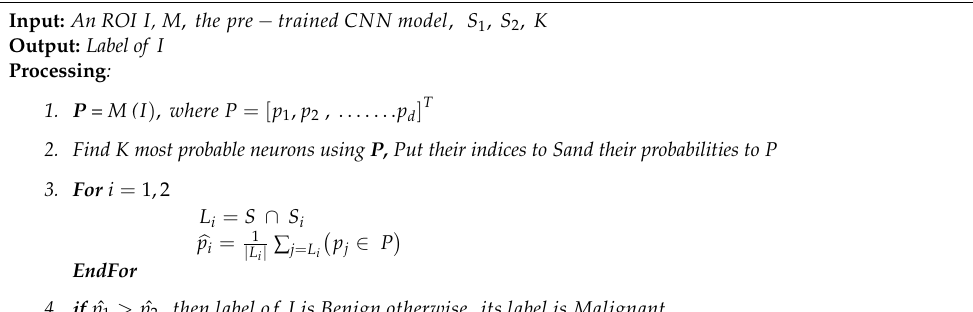
Algorithm 2: Testing Phase (The pseudo code of the testing method).